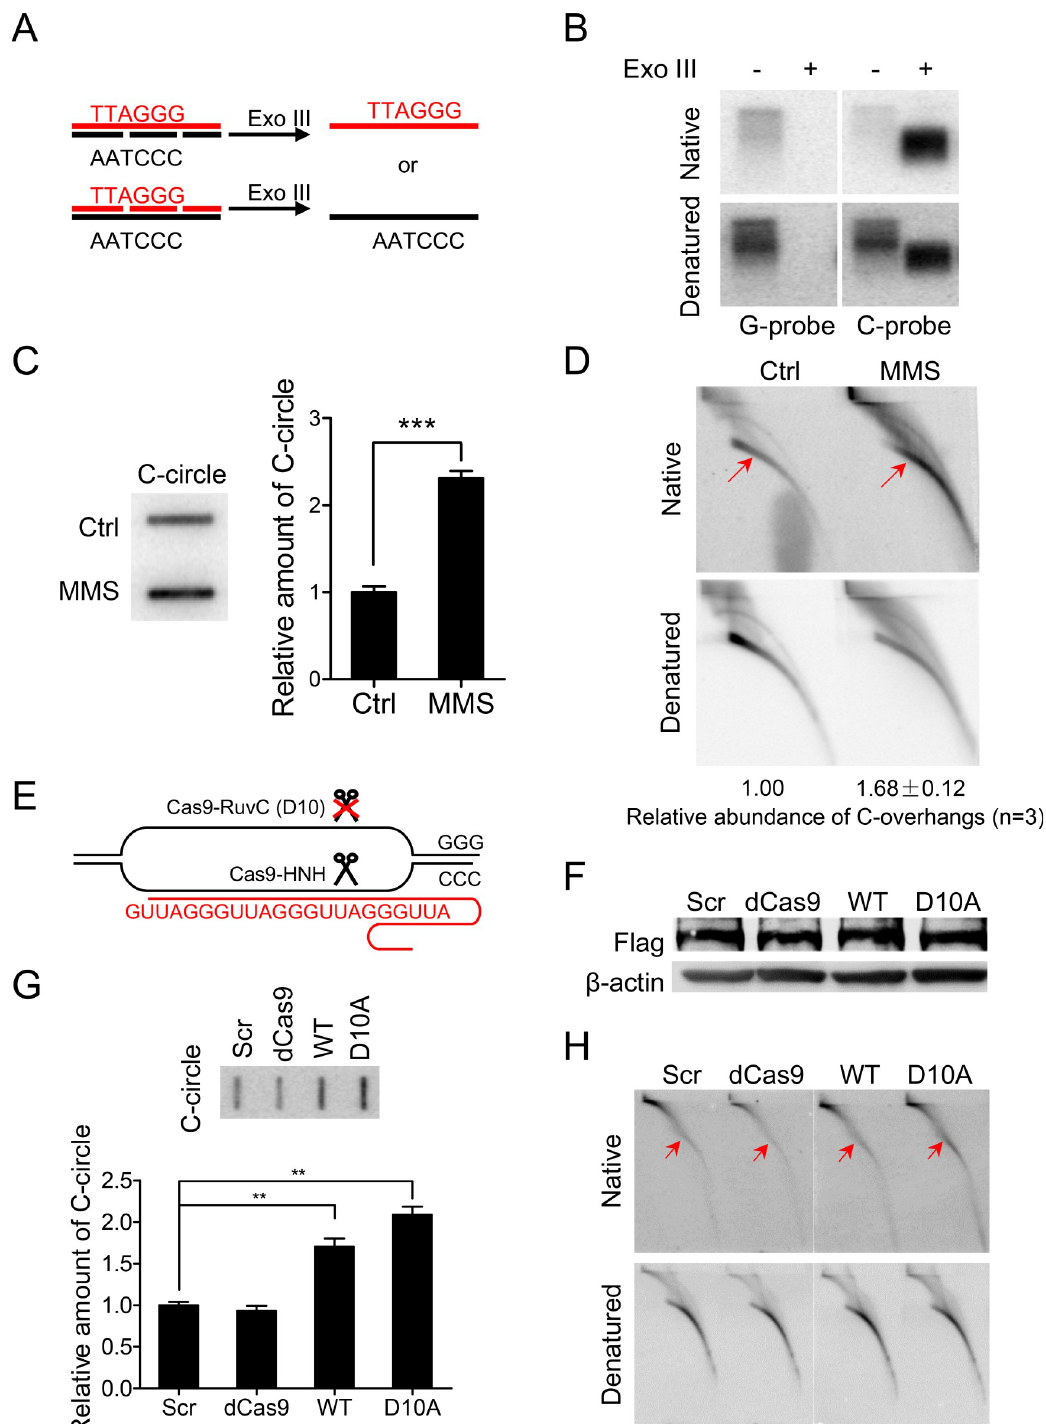
Fig 3. Endogenous ssDNA break/gap or induced ssDNA break in C-rich strand stimulates formation of C-circles and 5’ C- overhangs. (A) Experimental protocol to study strand specific (G-rich or C-rich) breaks/gaps on telomere is shown schematically. HinfI and RsaI digested genomic DNA was purified and further digested with Exo III to examine potential breaks/gaps on G- strand or C-strand of telomeres. If breaks/gaps occur on C-strand, Exo III would degrade all C-strand, leaving single-stranded G- strand that can be detected by hybridization with C-rich probe under native or denatured condition. Contrariwise, only C-strand can be detected if breaks/gaps occur on G-strand. (B) Breaks/gaps occur more frequently on C-rich strand of telomere. Exo